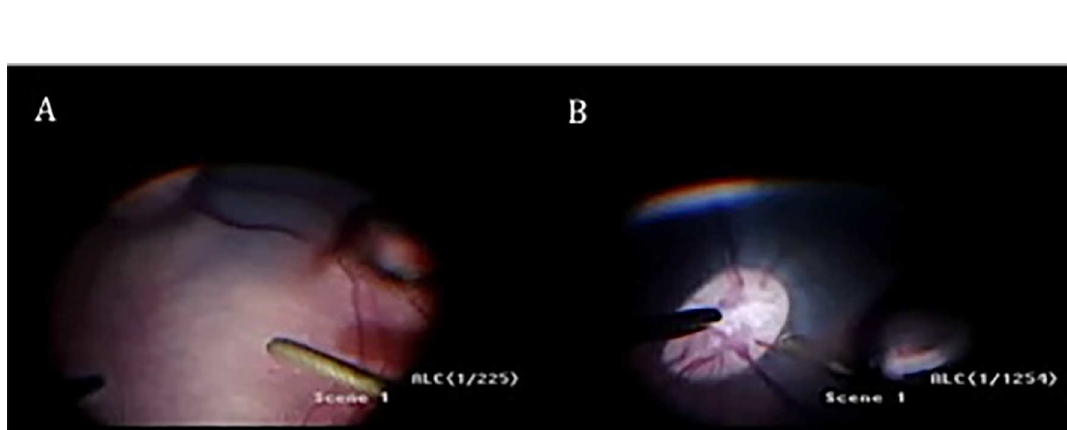
Fig 9. Non-recovery anaesthesia live animal experiments. (A) Shows the hypersonic vitrector over the macula and (B) Shows the hypersonic vitrector (HV) over ONH. Guillotineand hypersonic cutters were operated3–5 mm from the retina over the maculararea and the optic nerve head (ONH) for 5 minutes each (nasalarea served as control).